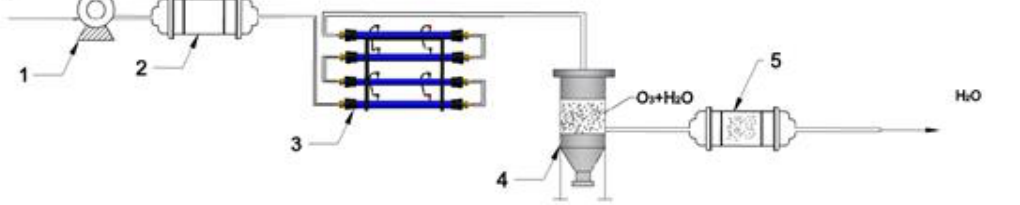
Figure 1. Ozonator installation “ Etro-03 ” based on electric corona discharge: 1 — dielectric tube; 2 —NО2 or H2O transformer oil travel space ; 3 — non-oxidizing tube; 4, 5 — cover made of brass; 6, 7 — cover made of dielectric material; 8, 9 — cover made of fluoroplastic material; 10 — sealing mate- rial stabilizing gate.